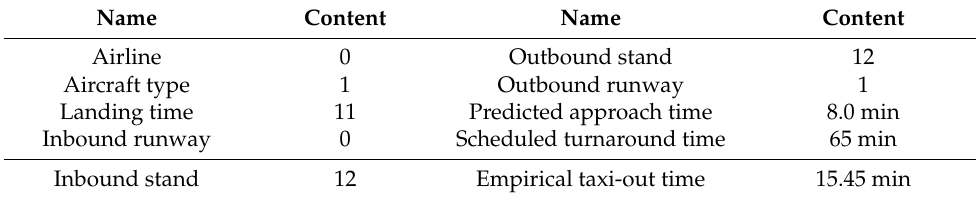
Table 7. Input data for the second phase imbalance data classification model.